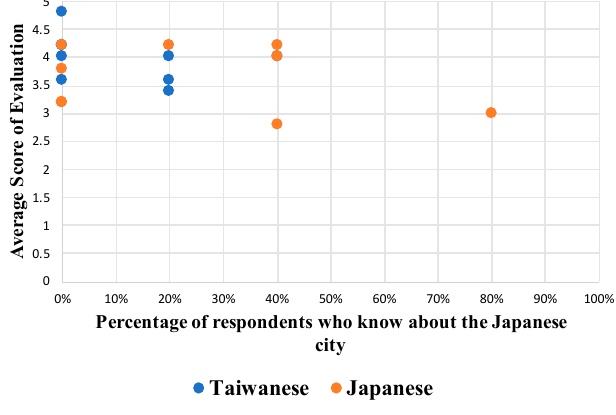
Figure 7. Evaluation result: Category 2.